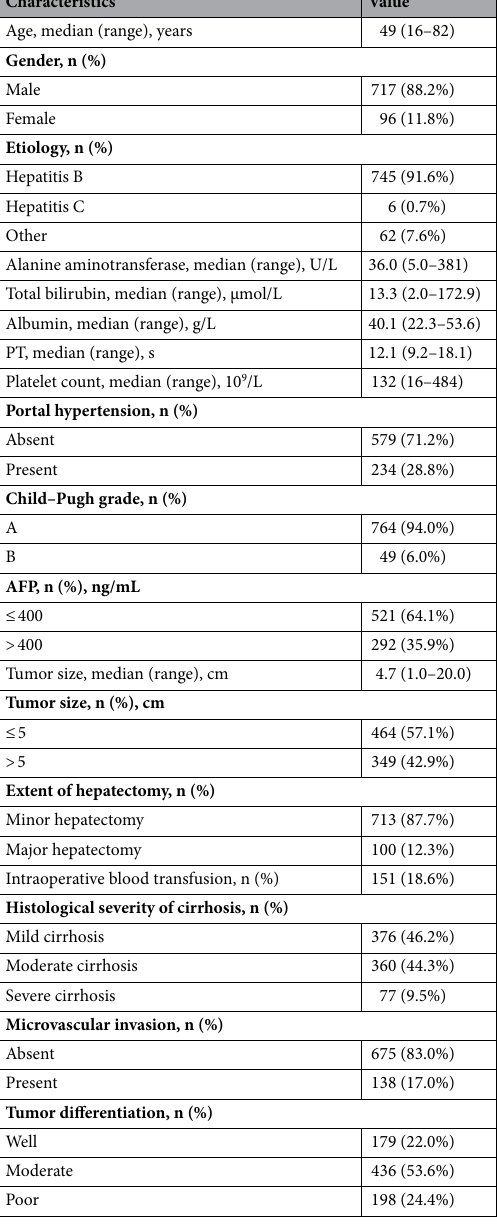
Table 1. Baseline characteristics of the entire cohort. PT prothrombin time, AFP